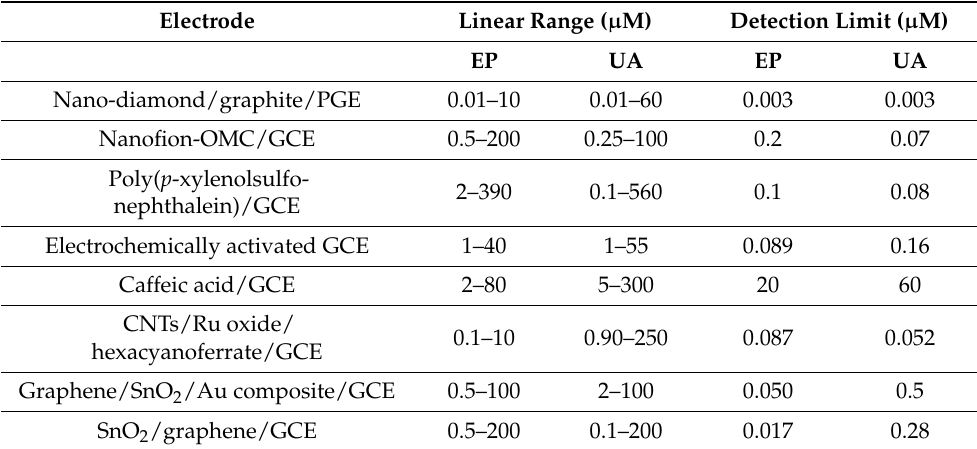
Figure 12. Schematic representation of the SnO 2 /graphene modified glassy carbon electrode for simultaneous detection of epinephrine (EP) and uric acid (UA). Reprinted from Sensors and Actuators B: Chemical, Vol 221, Lavanya N. et al., Simultaneous electrochemical determination of epinephrine and uric acid in the presence of ascorbic acid (AA) using SnO 2 /graphene nanocomposite modified glassy carbon electrode, Pages No. 1412–1422, Copyright (2015), with permission from Elsevier [128]. Table 2. Comparison of different chemically modified electrodes for EP and UA determination using SnO 2 /graphene/GCE. Reprinted from Sensors and Actuators B: Chemical, Vol 221, Lavanya N. et al., Simultaneous electrochemical determination of epinephrine and uric acid in the presence of AA using SnO 2 /graphene nanocomposite modified glassy carbon electrode, Pages No. 1412–1422, Copyright (2015), with permission from Elsevier [128].